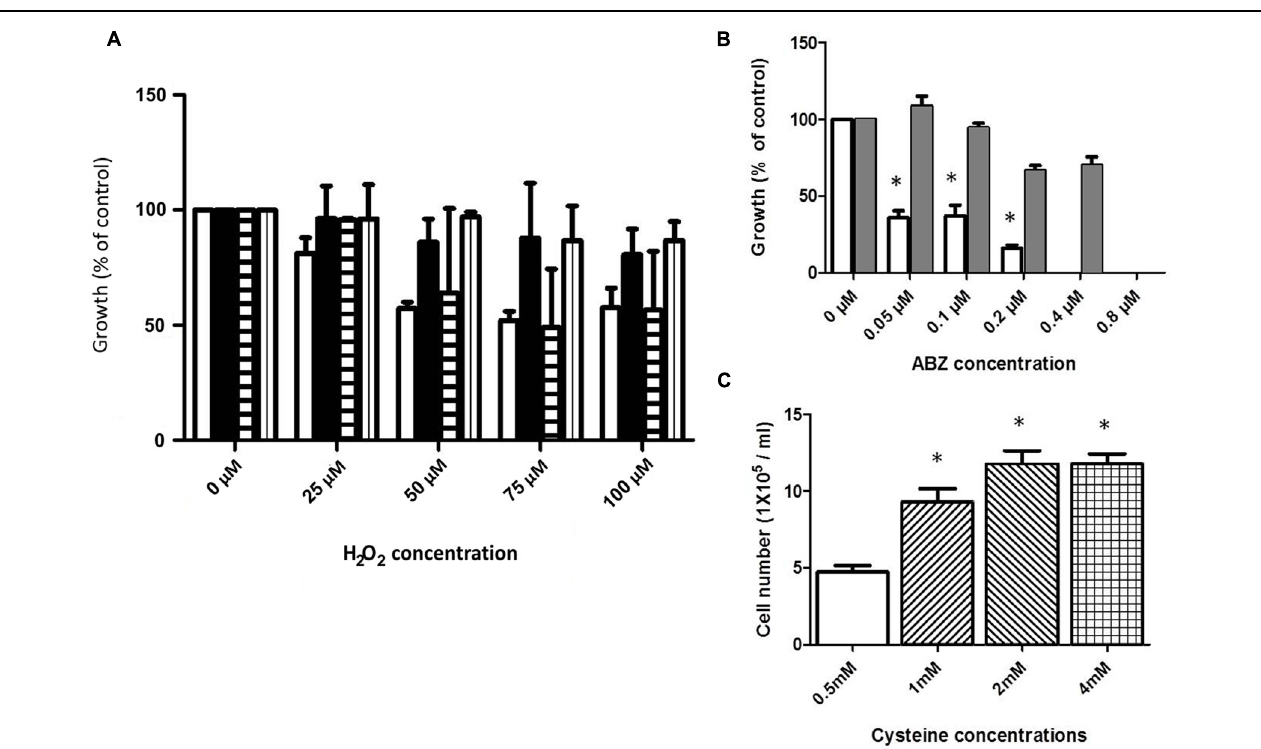
FIGURE 3 | Cross-resistance to ABZ and H 2 O 2 and cysteine (Cys) protection in trophozoites exposed to ABZ. (A) Cross-resistance to H 2 O 2 was evaluated in the ABZ-resistant clones R1.35 (black bars), R.8 (horizontal lined bars), and R.250 (vertical lined bars) previously obtained in our group (Paz-Maldonado et al., 2013). Parasites were exposed to the indicated H 2 O 2 concentrations for 24 h and the cell number was determined by SYTOX Green. As control, wild type WB strain (white bars) was incubated with the indicated H 2 O 2 concentration. (B) Cross-resistance to ABZ in a H 2 O 2 -resistant G. dudodenalis. A H 2 O 2 -resistant Giardia strain (ROX) was obtained by sub-culturing the WB strain in increasing H 2 O 2 concentration for 6 months. Control WB (white bars) and ROX (gray bars) trophozoites were exposed to the indicated increasing ABZ concentrations for 24 h and the cell number was determined using the